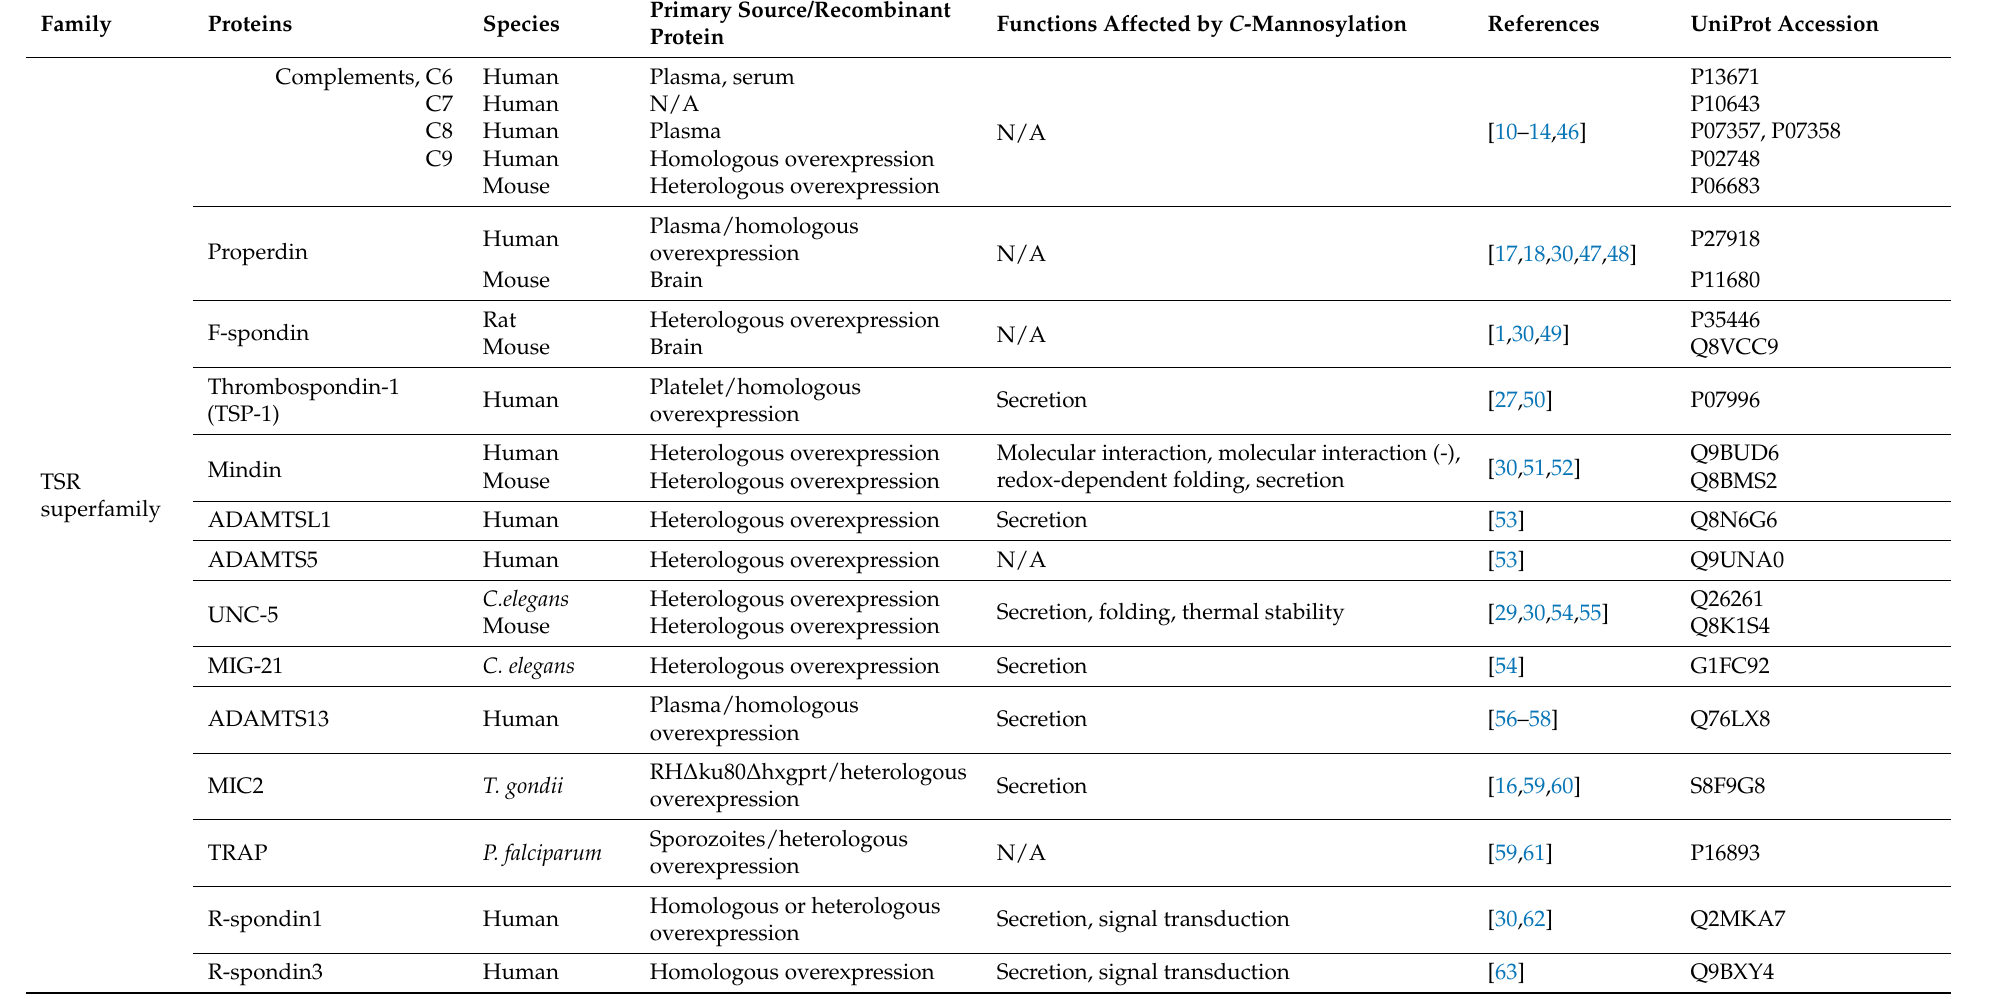
Table 1. List of proteins that can be C